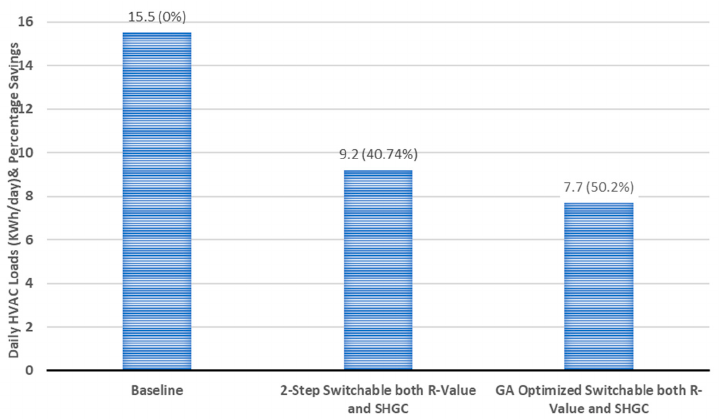
Figure 5. Reducing loads for optimized STIS–smart windows applied to a house in Golden, CO, USA—21 May.